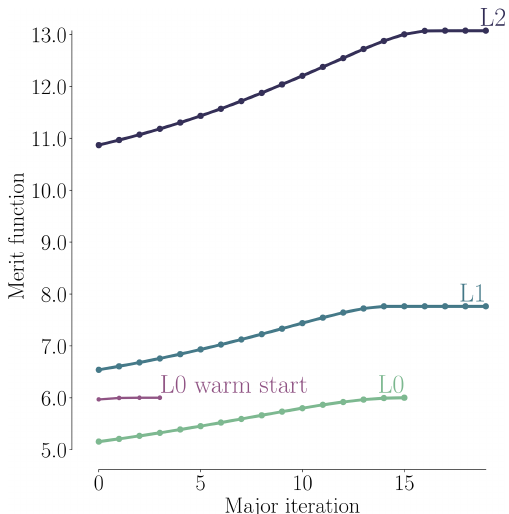
Figure 9. Merit function history as a function of steps taken by the